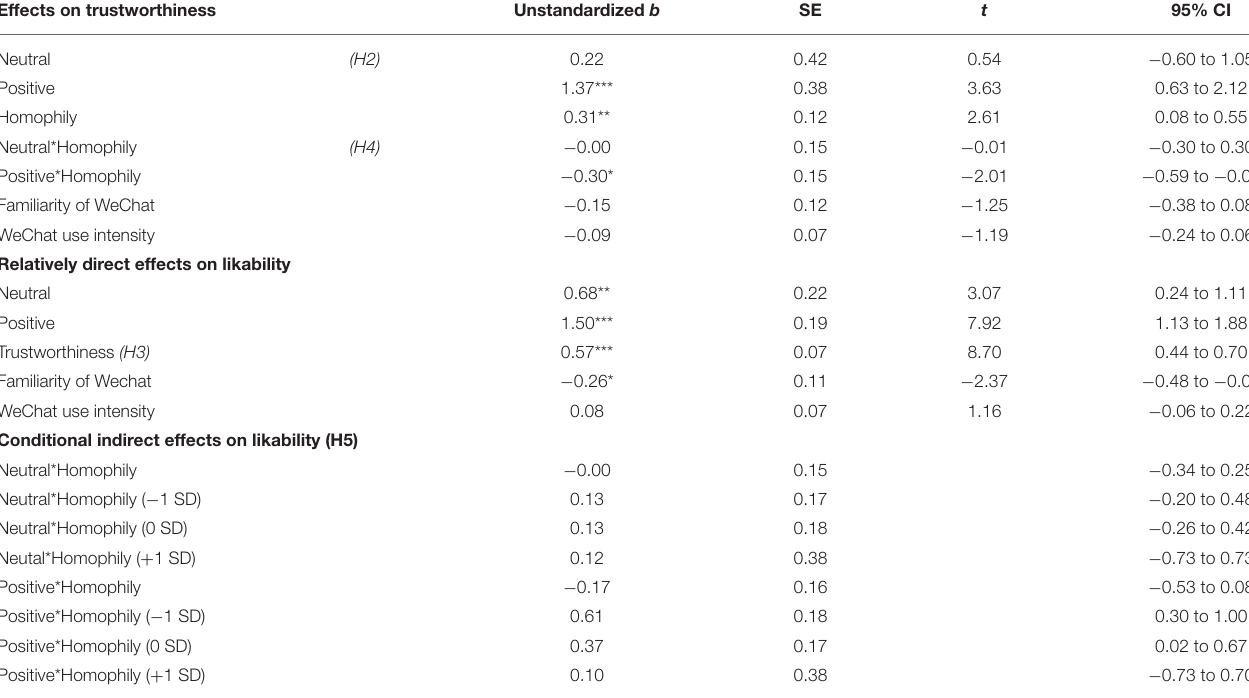
TABLE 1 | Moderated mediation effect of trustworthiness on likability. Effects on